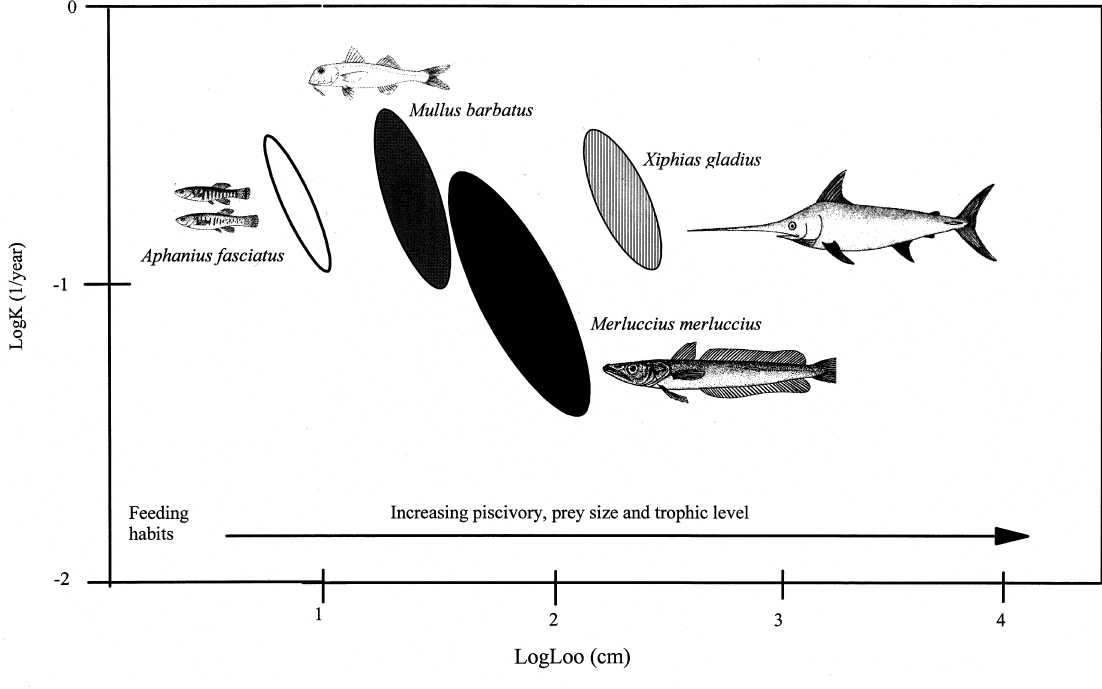
Fig. 7. Auximetric grid showing asymptotic growth surfaces for four species in the Hellenic